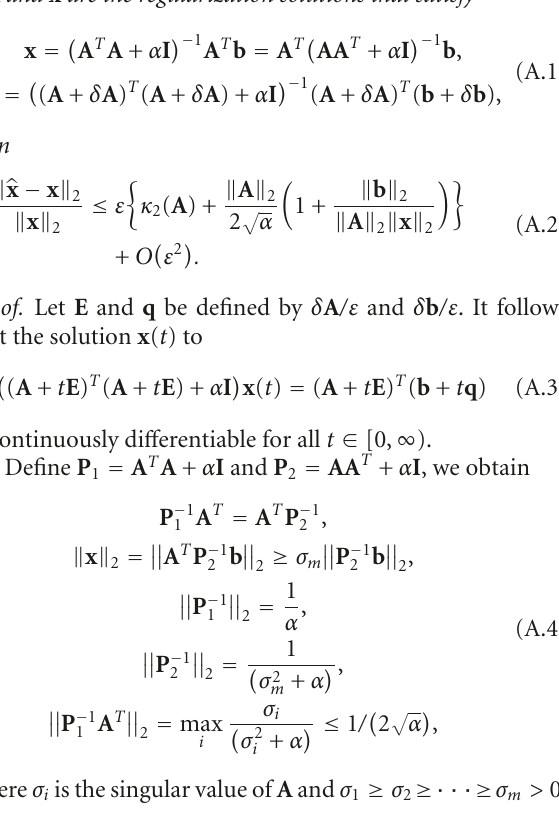
Figure 4: The profile of PSNR versus the number of iterations with di ff erent forgetting parameters λ = ζ 1 / 5 , where ζ = { 0 . 6,0 . 8,1 . 0 }